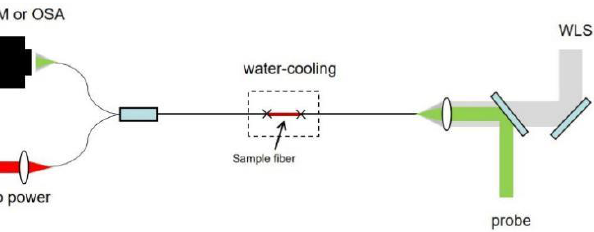
Figure 11. Setup for the pump-probe and the absorption spectrum experiment. PM, power meter; OSA, spectrometer; WLS, white light source.